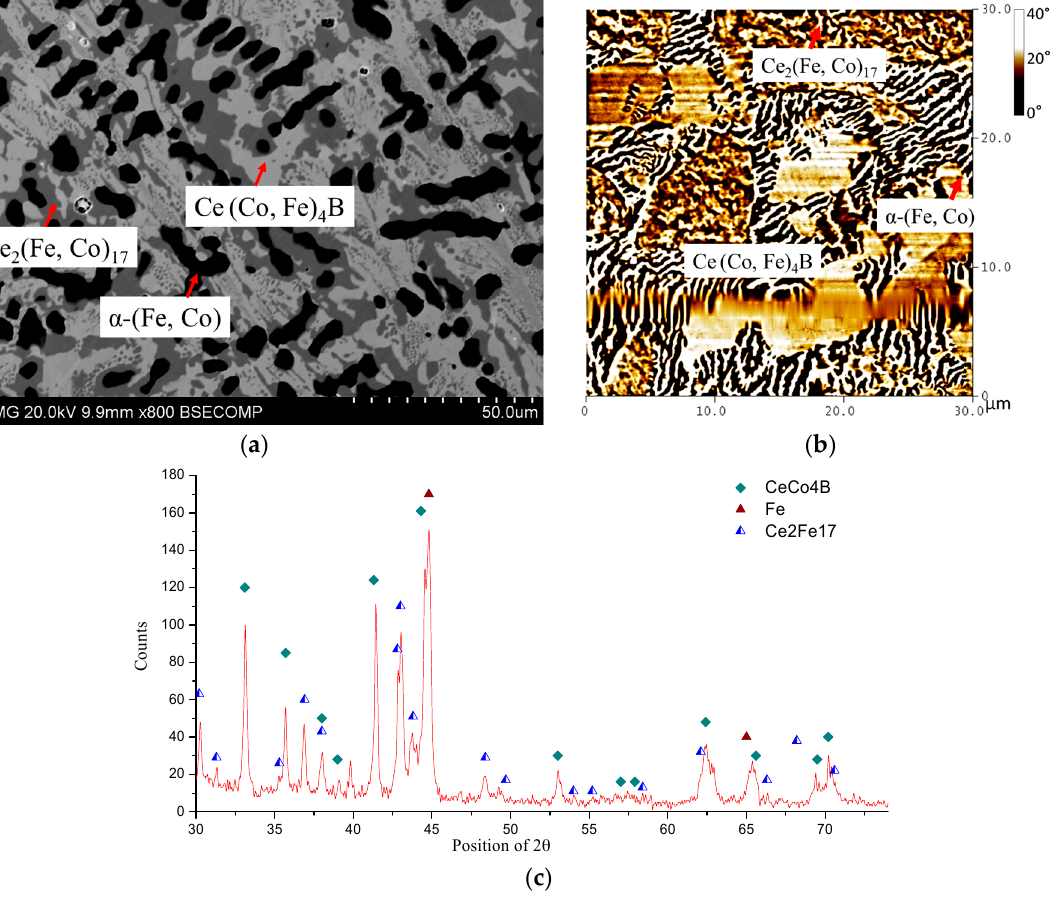
Figure 15. ( a ) BSE image of KA 6; ( b ) MFM image of KA 6; ( c ) XRD spectrum of KA 6.